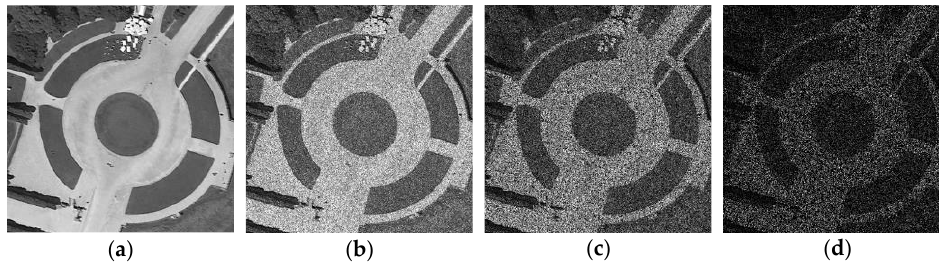
Figure 3. Illustration of the Bernoulli-sampled speckled image pairs. ( a ) Underlying clean image X (unseen by our proposed SSD-SAR-BS). ( b ) Synthetic speckled image Y corrupted by four-look speckle noise. ( c , d ) Speckled input and target images ( ˆ Y , ˜ Y ) generated by the Bernoulli sampling with p =